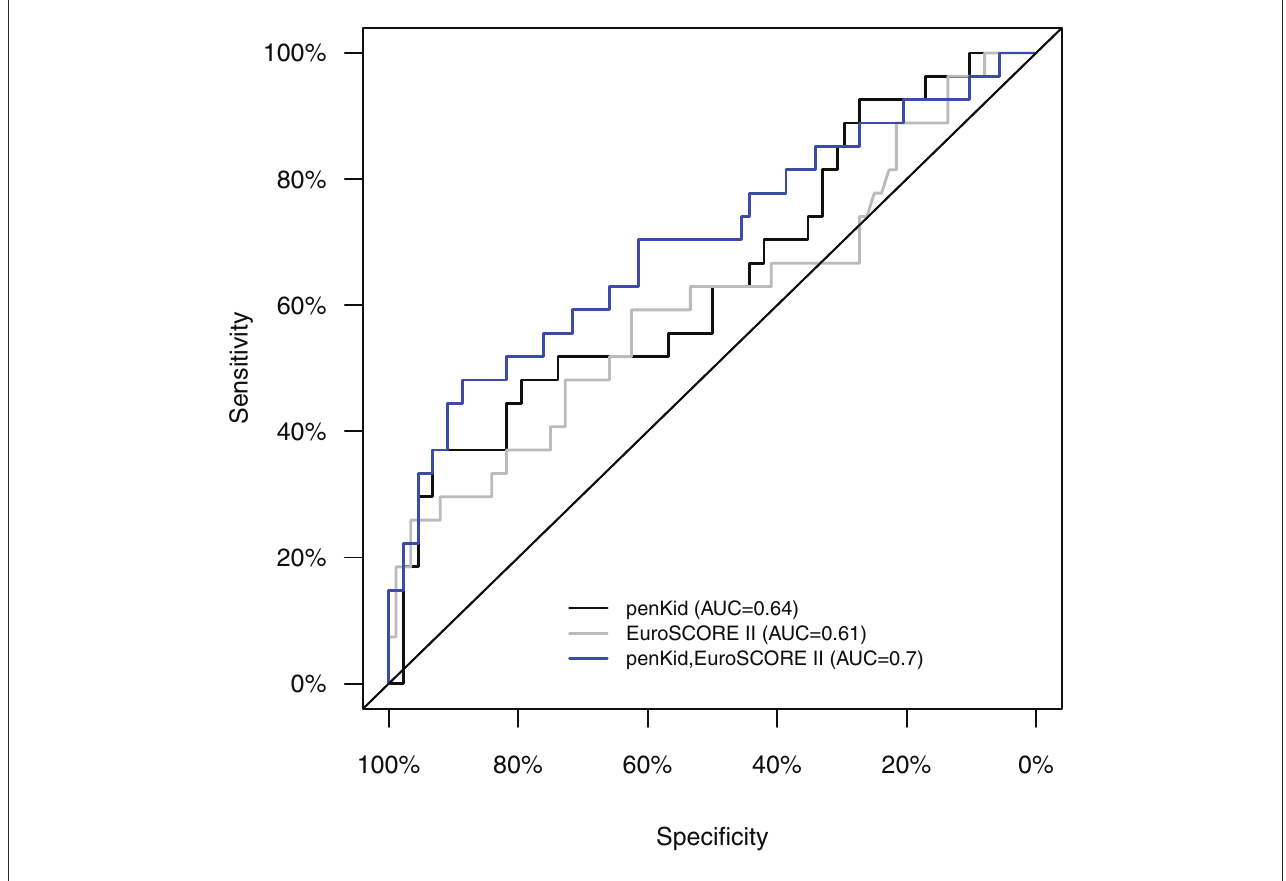
FIGURE2 AUC/ROC analysis of intraoperative levels of penKid and EuroSCORE II alone (S2) and a combination of penKid (S2) with preoperative EuroSCORE II for the combined outcome “ICU length of stay > 1 day or in-hospital death.” AUC/ROC, area under the curve/receiver operating characteristics; penKid, proenkephalin A; S2, intraoperatively at the end of cardiopulmonary bypass; EuroSCORE II, preoperative European System for Cardiac Operative Risk Evaluation Score II.